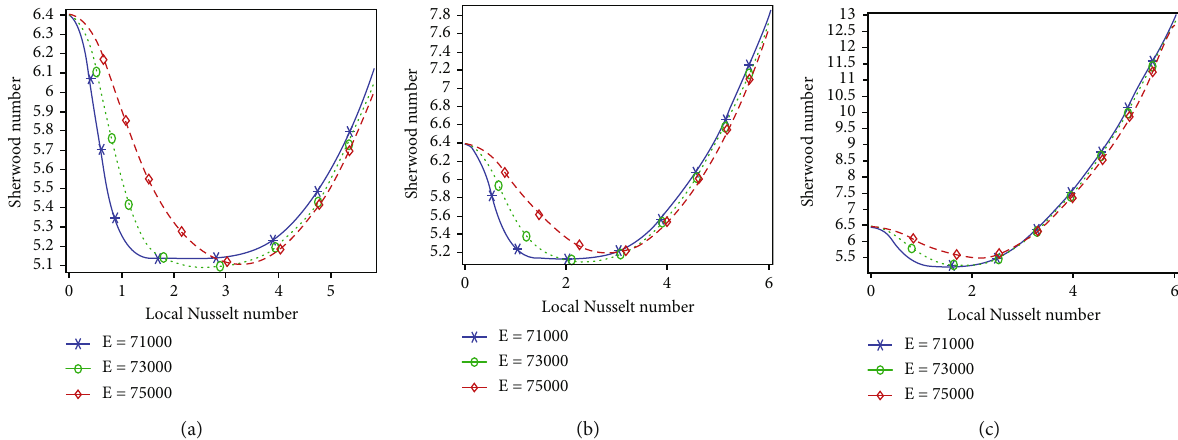
Figure 16: Sherwood number vs. the local Nusselt number at upstream along the backward step channel against the axial direction at (a) Re = 100 , I : C = 1 % , a = 0 : 5 ; (b) Re = 100 , I : C = 1 % , a = 0 : 6 ; and (c) Re = 100 , I : C = 1 % , a = 0 : 7 .